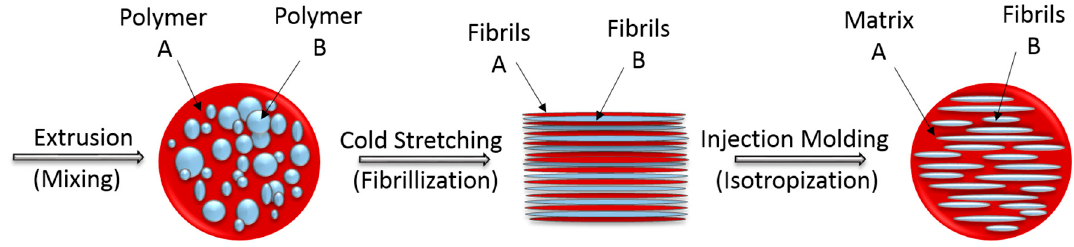
Figure 1. Scheme of MFC preparation [27,28].